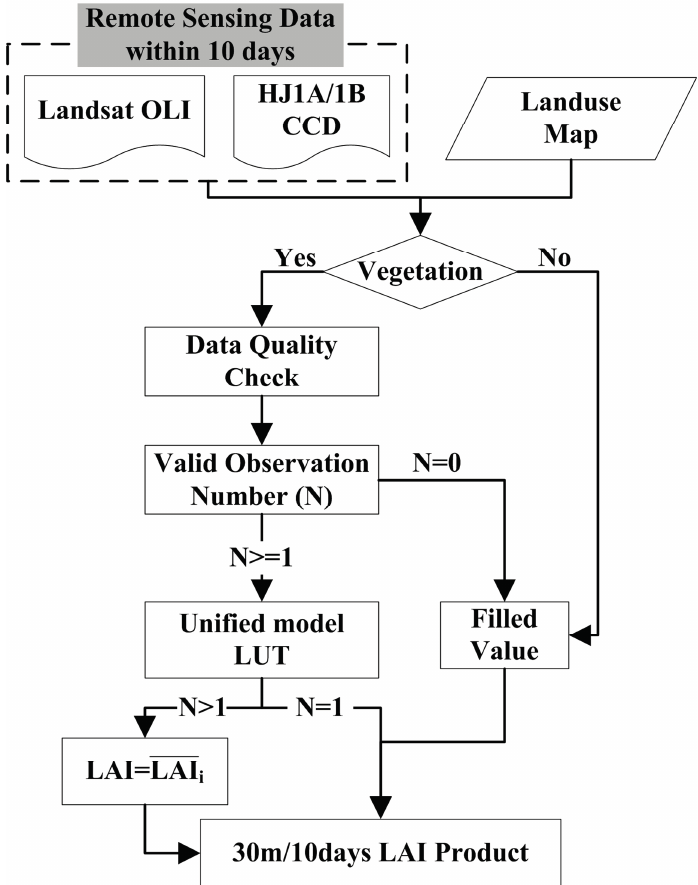
Figure 1. Flowchart of the LAI retrieval algorithm from the 30 m resolution multi-sensor